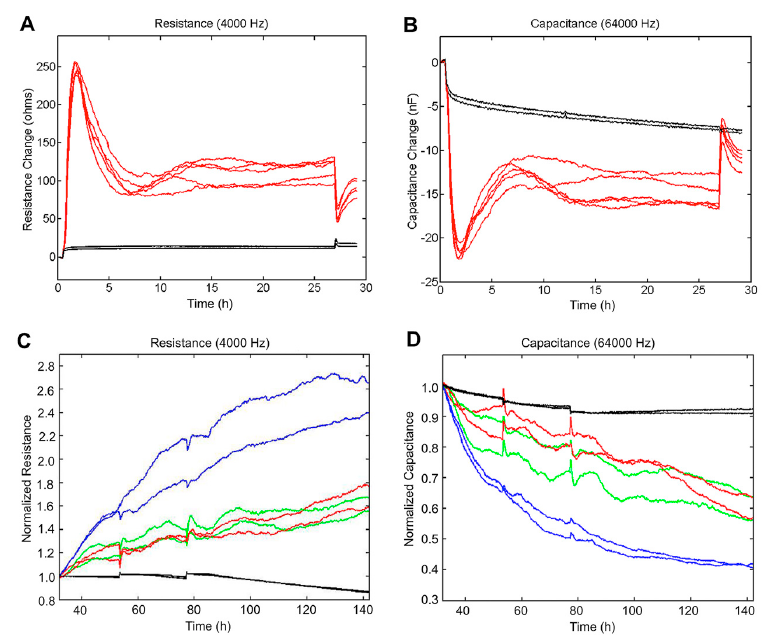
Figure 7. ECIS measurements with HTPCs and e ff ects of treatment with Dex ( A , B ). Characterization of HTPC growth after seeding of HTPCs onto ECIS electrodes (0 h). Barrier resistance representing the tightness of cell-to-cell contacts, was measured at 4000 Hz, after preliminary experiments to optimize resistance measurements ( A ) and capacitance at 64,000 Hz ( B ). Black lines correspond to the cell-free controls. After 27 h, 1 µ M Dex was added. EtOH-treated and untreated cells served as controls. ( C ) Resistance at 4000 Hz after application of Dex compared to control cells normalized at t = 32 h. Red curves correspond to the untreated control cells, green curves to EtOH-control cells, and blue curves to Dex-treated cells. ( D ) Capacitance at 64,000 Hz in Dex-treated and control HTPCs normalized at t = 32 h. The black lines in panels C–D correspond to the cell-free controls. In parallel experiments performed with a second HTPC line, similar results were obtained.